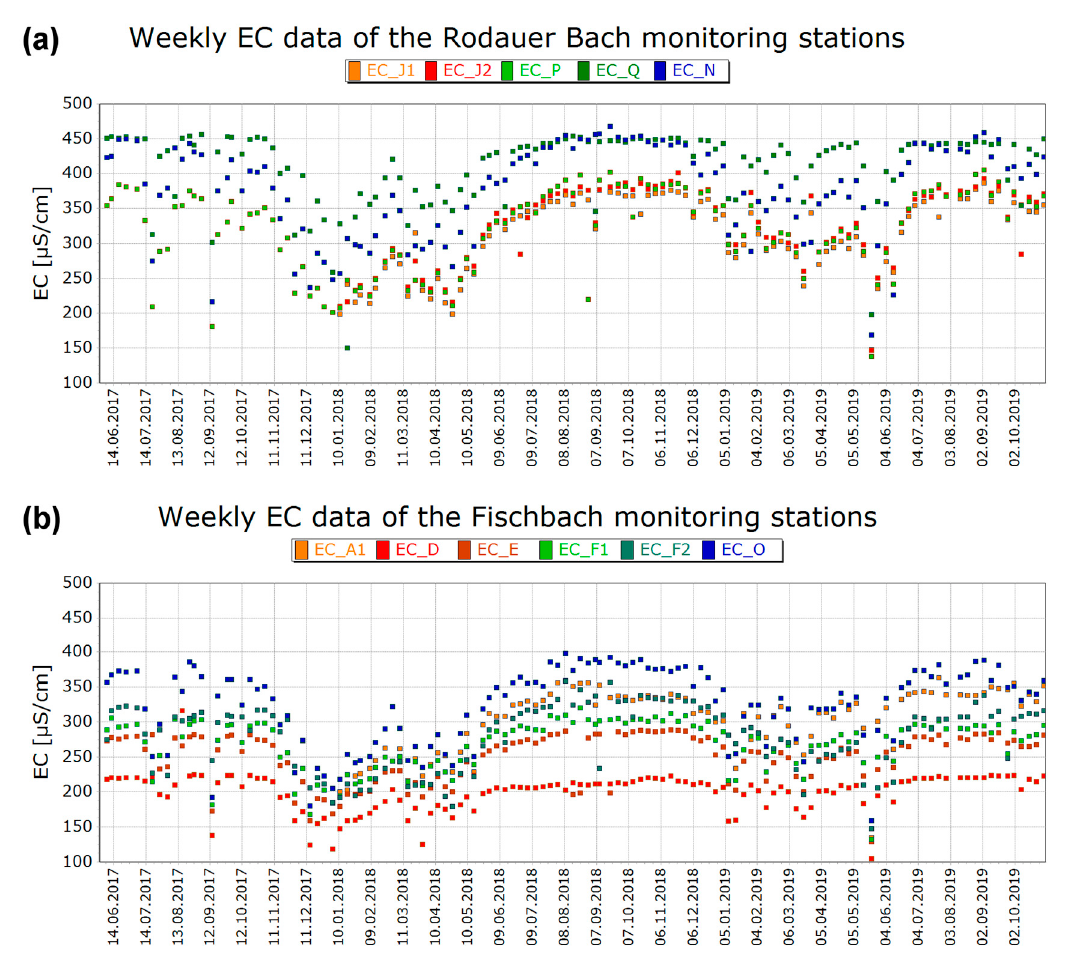
Figure 7. Weekly electric conductivity (EC) measurements at monitoring stations along ( a ) the Rodauer Bach and ( b ) the Fischbach.